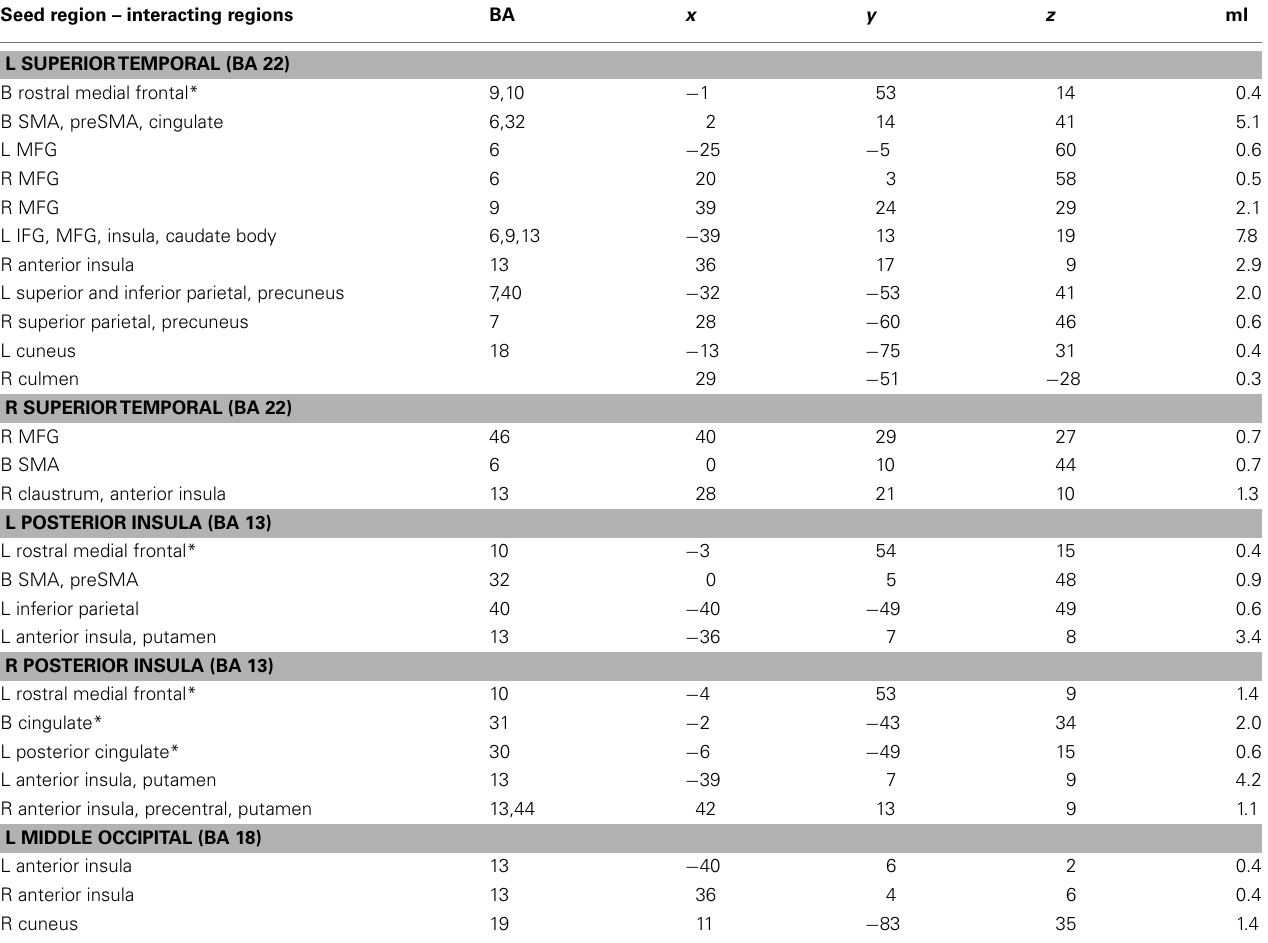
Table 3 | Regions showing effective connectivity with cortical ROI that was modulated by the effects of time dilation and compression on perceived duration (V–A